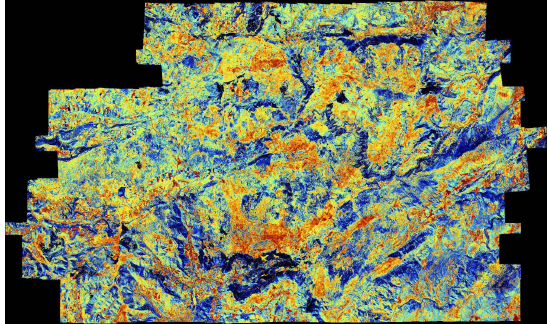
Figure 9d: Our result rendered with